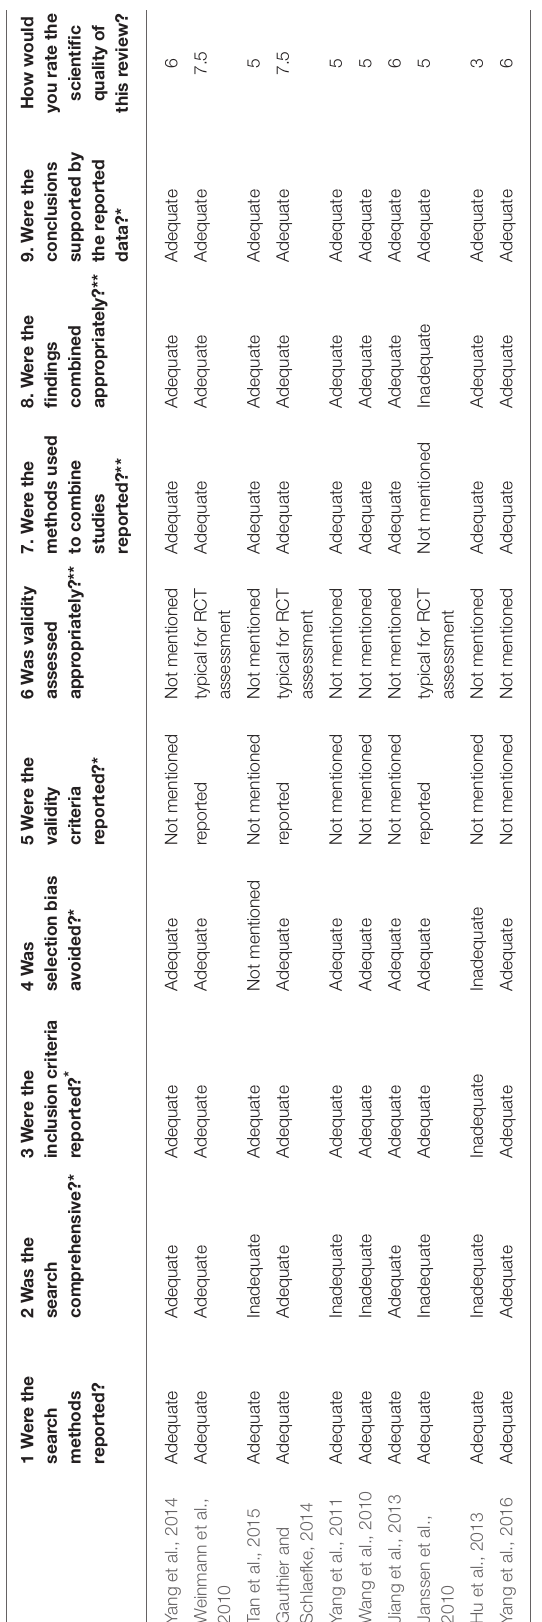
(1) Global clinical assessment: Two systematic reviews (Gauthier and Schlaefke, 2014; Yang et al., 2016) indicated that the effectiveness of EGb 761 was better than that of placebo. Yang et al. (2016) indicated that there was no significant difference comparing EGb 761 with WCM; however, this study is not